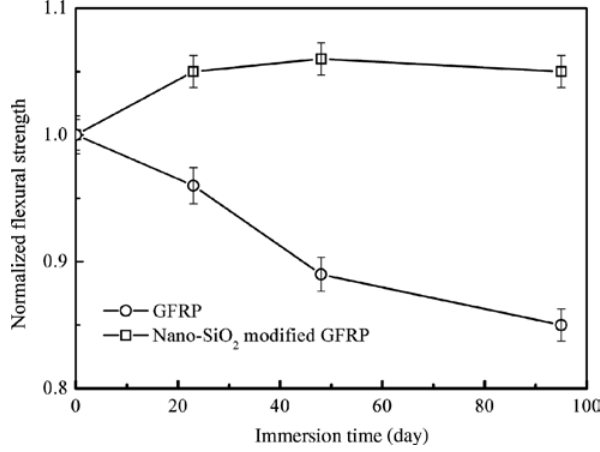
Figure 9: Normalized flexural strength as a function of the immer- sion time for the GFRP composites.